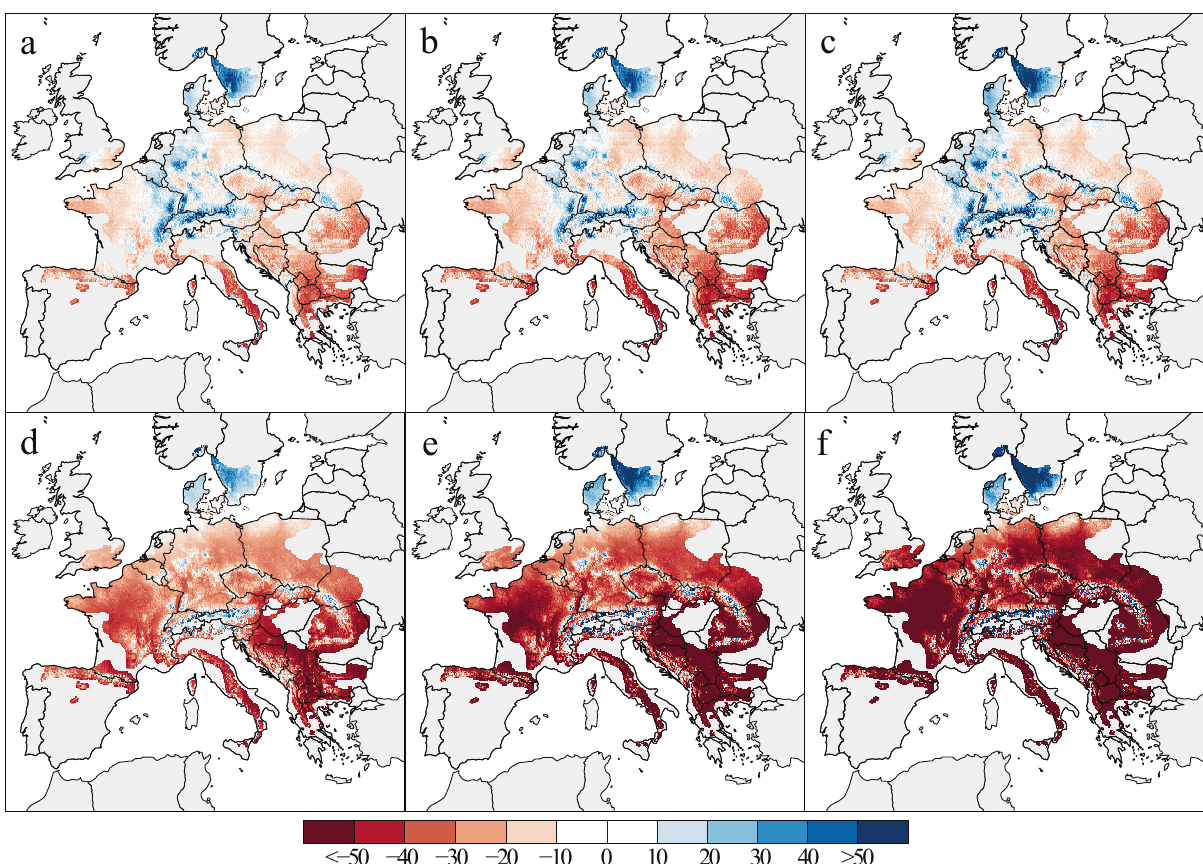
Fig. 4 Relative changes in tree growth. Changes are projected under SSP1-2.6 ( a – c ) and SSP5-8.5 ( d – f ) CMIP6 climate scenarios for different periods: 2020 – 2050 ( a , d ), 2040 – 2070 ( b , e ), and 2060 – 2090 ( c , f ) In this panel, BAI changes were expressed in percentage of change compared to the 1986 – 2016